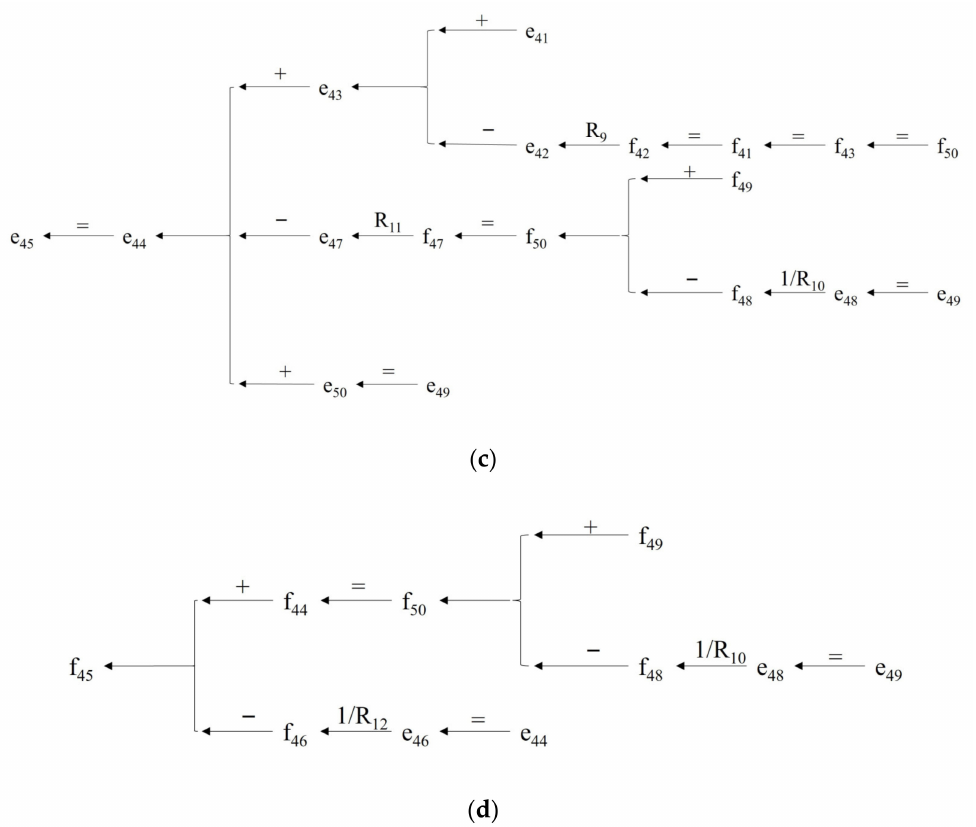
Figure 19. The variable relationship graph of the reactor coolant pump: ( a ) in the motor module; ( b ) in the mechanical module; ( c ) in the hydraulic module (effort); ( d ) in the hydraulic module (flow).